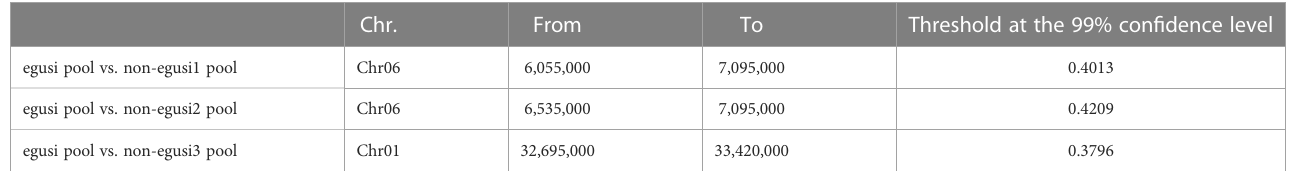
TABLE 2 QTLs identi fi ed by BSA-seq.